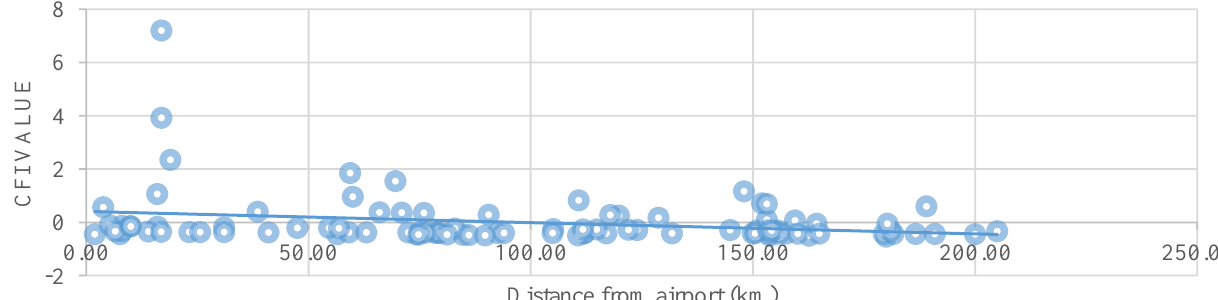
Figure 9. Change in CFI with respect to distance from airport .